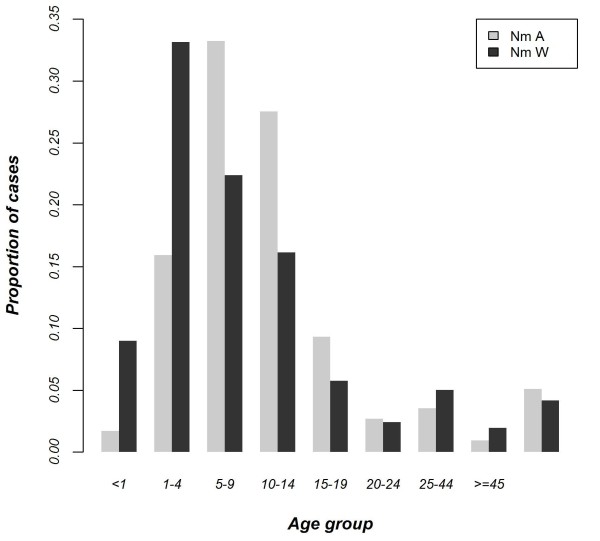
Age groups affected by
N. meningitidis
serogroups A (N = 2964) and W (N = 1077) from 2008 to 2011.